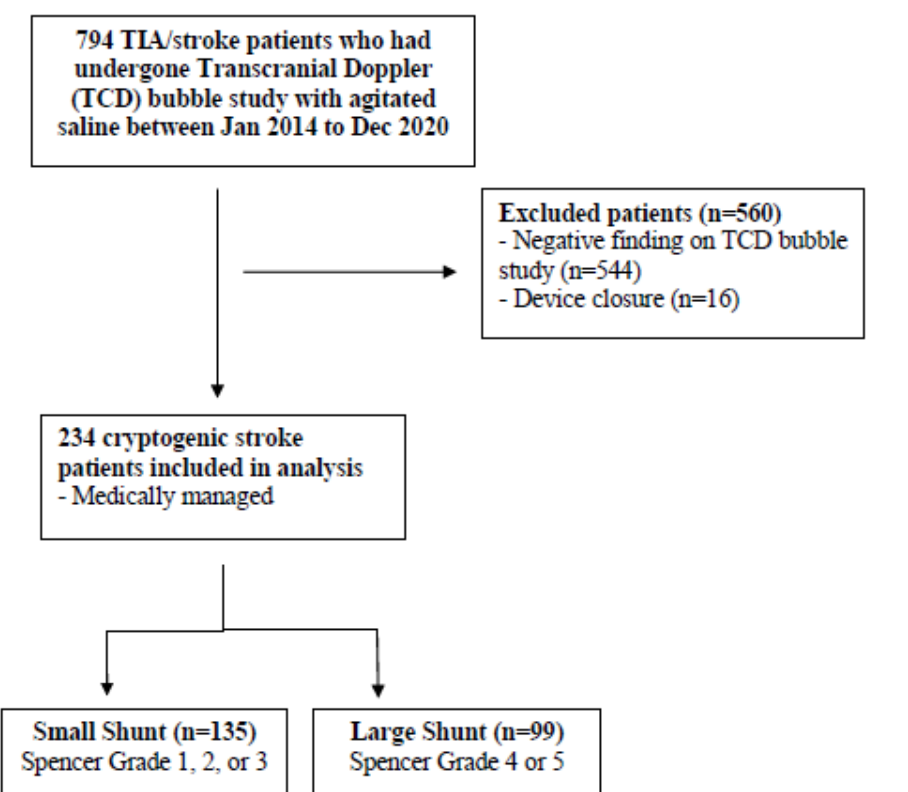
Figure 1. Flowchart showing patient selection, patient inclusion, and exclusion criteria.